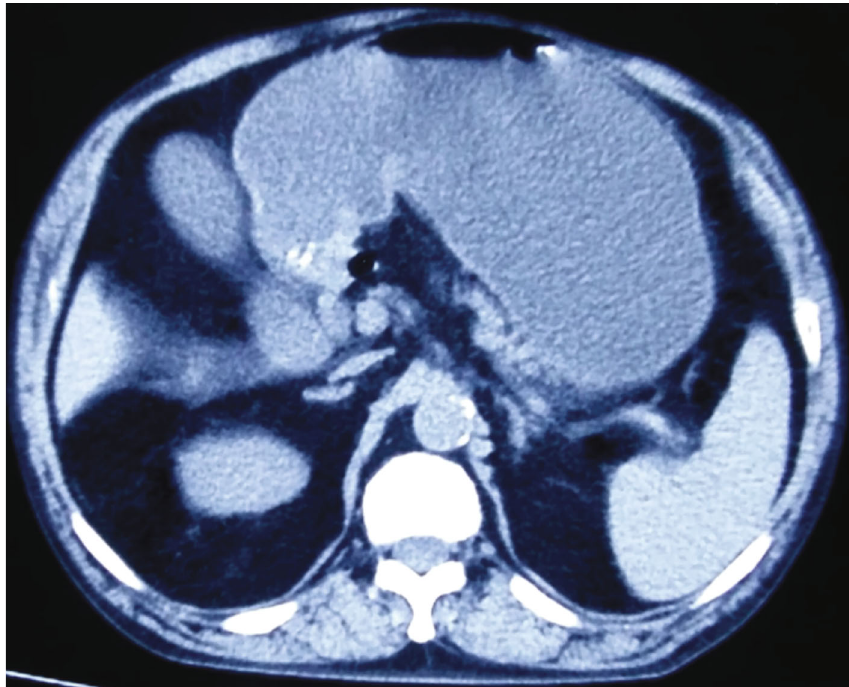
Figure 1: CT image showing distended stomach, concentric thickened pylorus without mass lesion, and an atrophic pancreas.